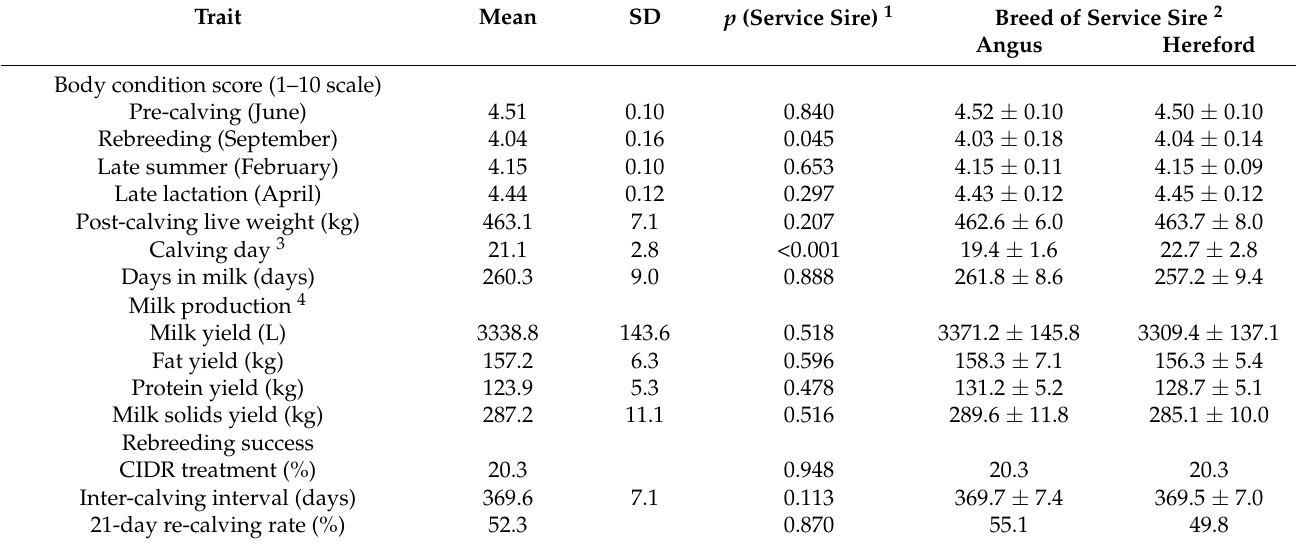
Table 1. Mean and standard deviation (SD) of the service sire mean and mean (±SD) of service sires within each breed for body condition score, post-calving live weight, milk production, rebreeding success, and survival traits.